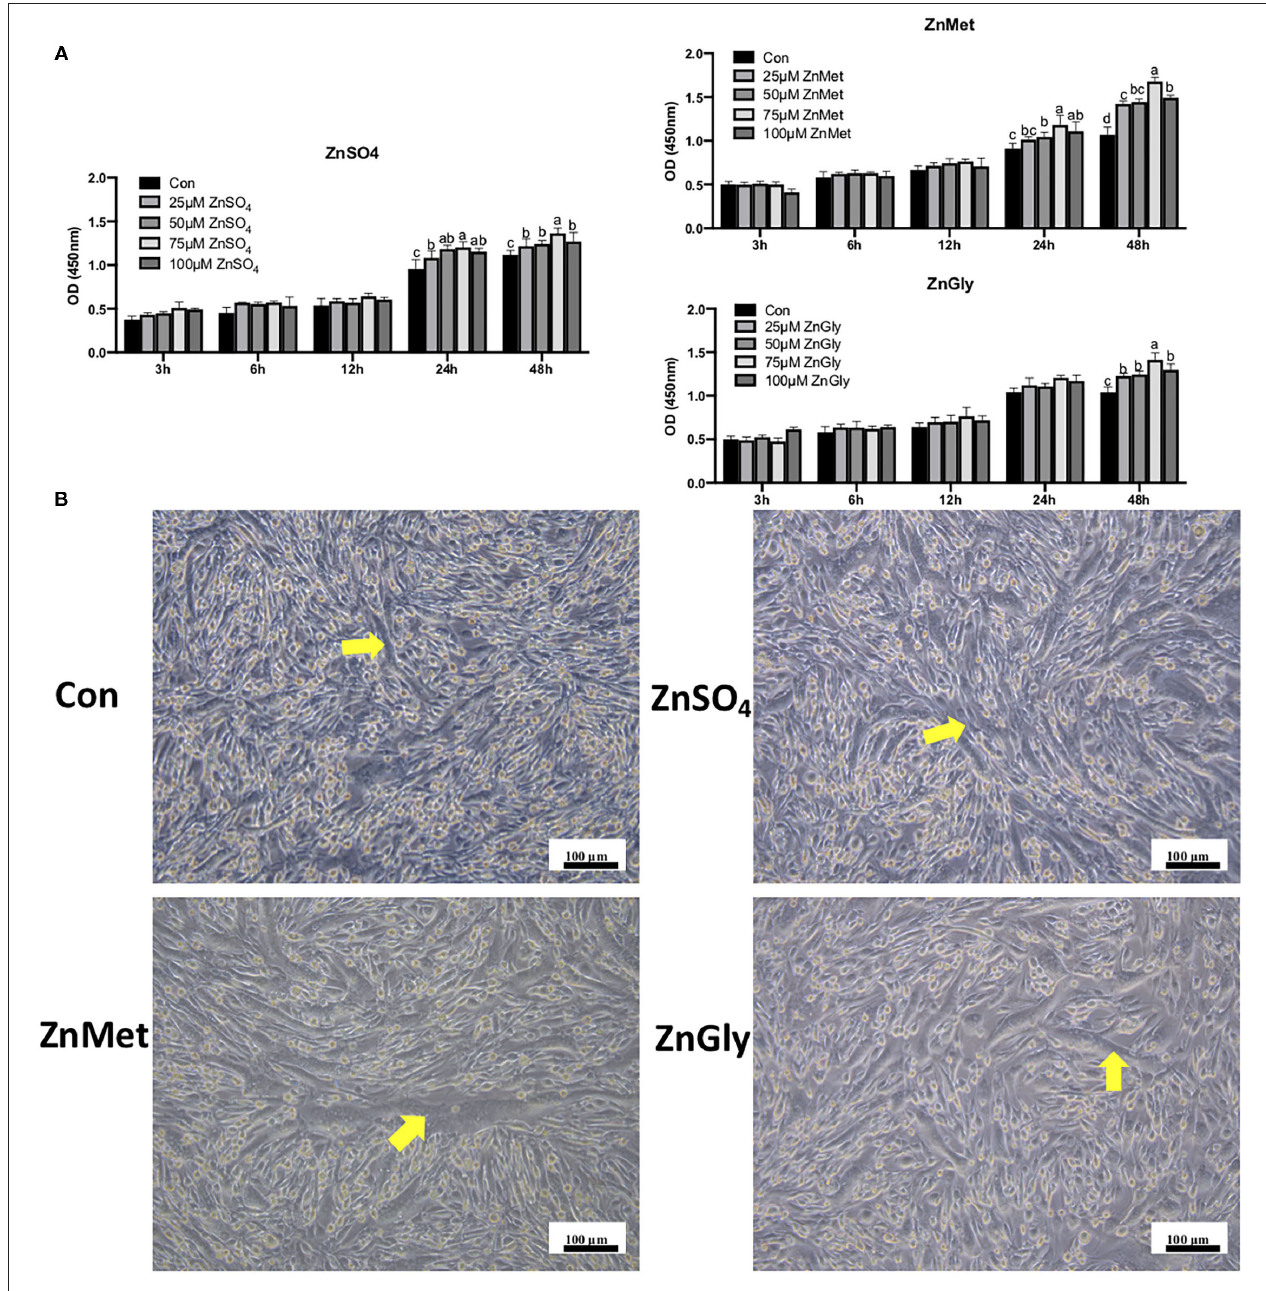
FIGURE 1 | CCK-8 (A) in cell proliferation and morphological responses in cell differentiation (B) of C2C12 cell line by adding different zinc sources.